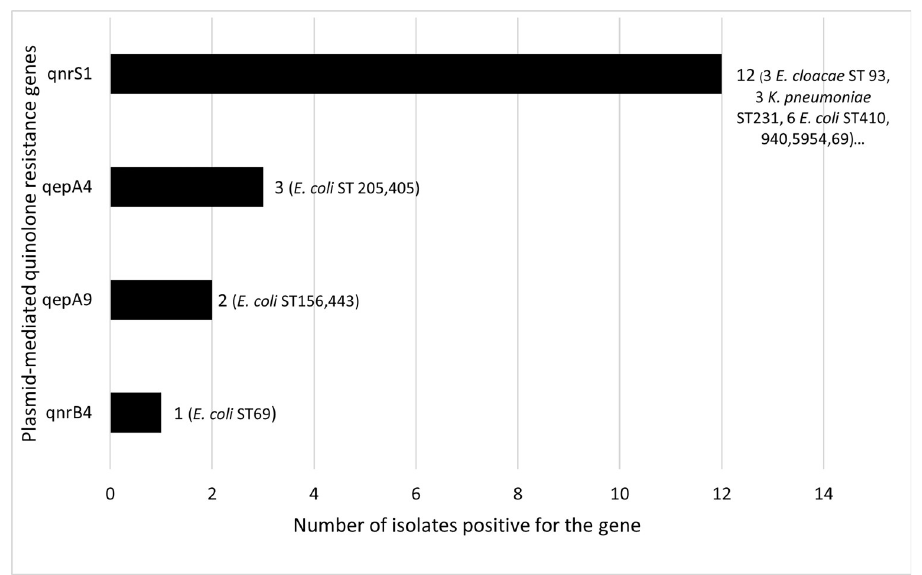
Fig 4. Bar plot depicting the distribution of plasmid-mediated quinolone resistance genes.